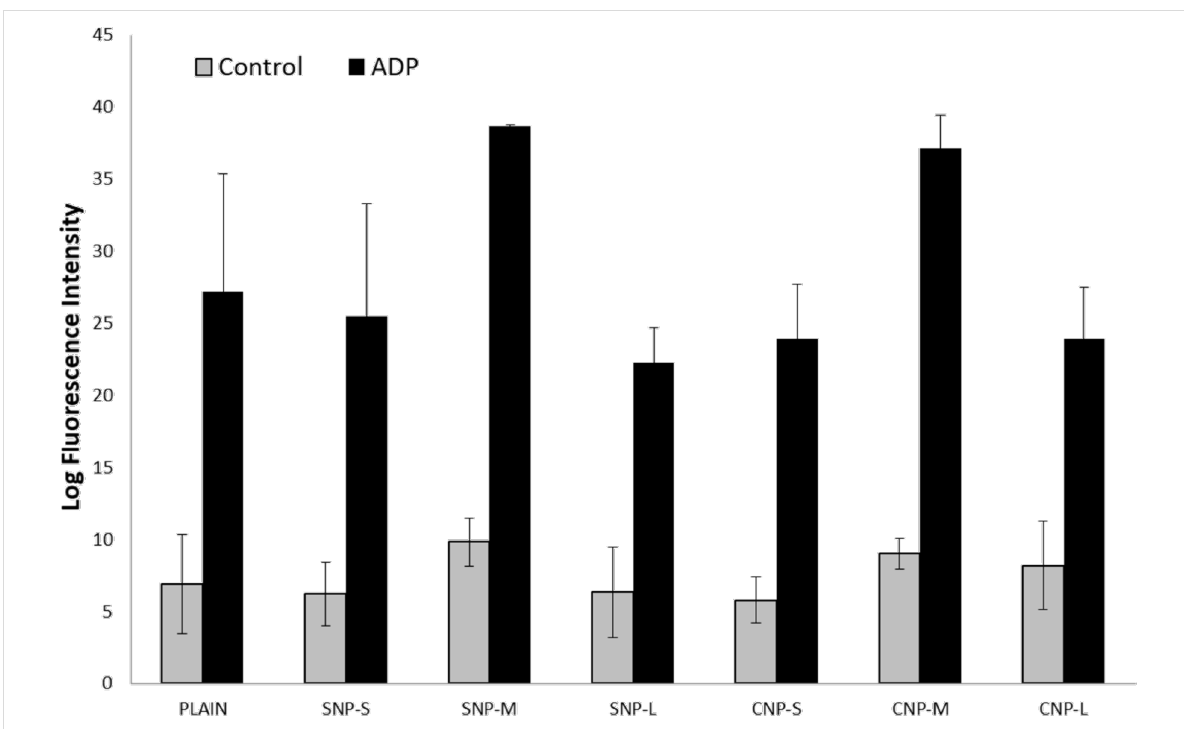
Figure 10: Effect of the nanoparticles on platelet activation measured as secretion of